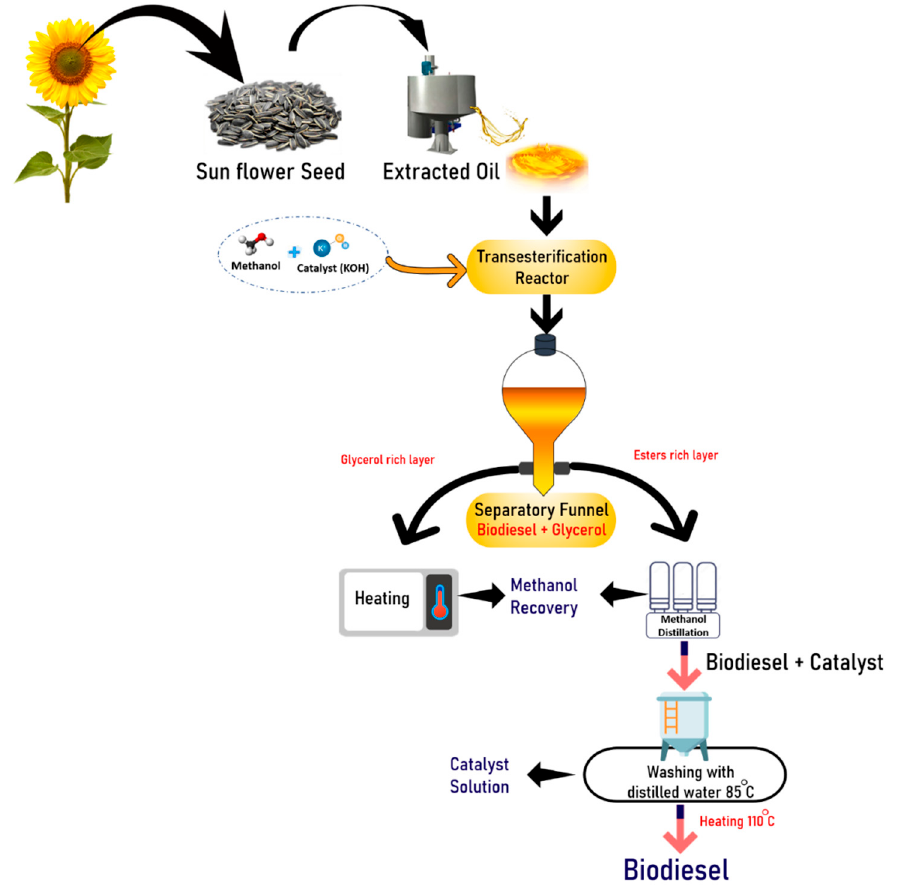
Figure 3. Biodiesel production from sunflower seeds through transesterification reactor. Table 3. Lignocellulosic biomass biorefinery (Phase I, II and III).